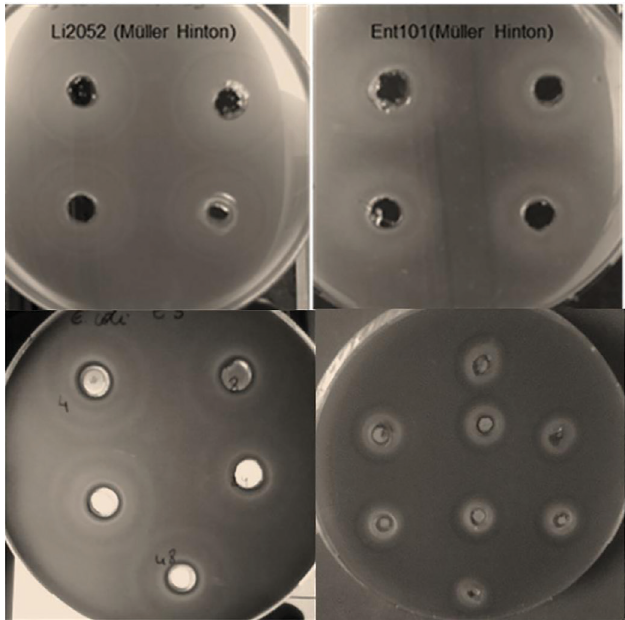
FIGURE 1 - Antimicrobial activity of bacteriocin extract produced by Pediococcus pentosaceus ATCC 43200 after 24 h of cultivation in G-MRS medium against Listeria innocua 2052 (Li2052), Enterococcus 101 (Ent101) and Escherichia coli ATCC 25922 ( E. coli ). Tests were performed by agar-well- diffusion assay carried out on Muller Hinton (Enterococcus and Listeria strains) and MacConkey ( E. coli ) agar-media. (A, C, E = indicator strain at OD 0.3); (B, D, F = indicator strain diluted 100 times from OD 0.3).